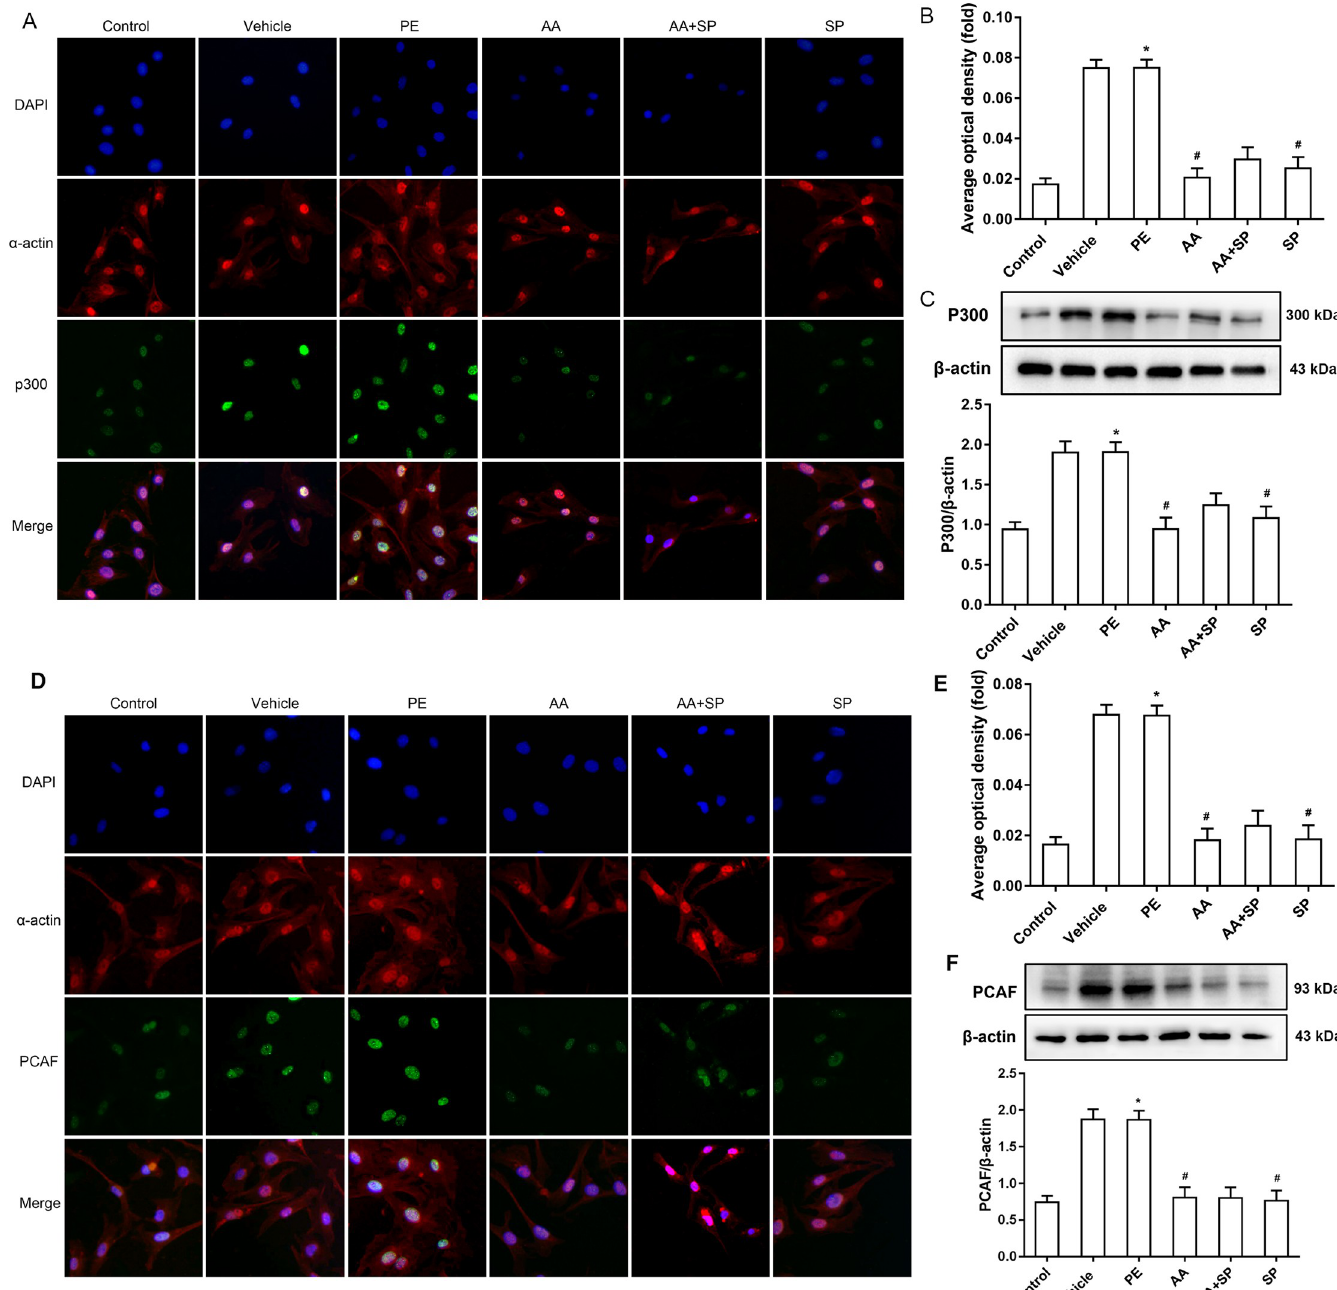
Fig 4. Effects of anacardiac acid (AA) and the JNK inhibitor SP600125 on the expression of HATs in phenylephrine (PE)-induced hypertrophic cardiomyocytes. (A) P300 (green fluorescence) and α -actin (red fluorescence) combined with DAPI (blue fluorescence) staining of myocardial cells exposed to six different conditions. Scale bars, 20 μ m. (B) The statistical analysis of average optical density of P300 immunofluorescence in the six groups. (C) The levels of P300-HAT (histone acetyltransferase) significantly increased in the hypertrophic cardiomyocytes induced by PE; the HATs inhibitor AA and the JNK inhibitor SP600125 prevented this effect. (D) PCAF (green fluorescence) and α -actin (red fluorescence) combined with DAPI (blue fluorescence) staining of myocardial cells exposed to six different conditions. Scale bars, 20 μ m. (E) The statistical analysis of average optical density of PCAF immunofluorescence in the six groups. (F) The level of PCAF-HAT was increased significantly in hypertrophic cardiomyocytes induced by PE compared to that in control cells. The HATs inhibitor AA or the JNK inhibitor SP600125 normalized the expression of PCAF-HAT in PE-induced hypertrophic cardiomyocytes. � P < 0.05 vs . the control group, # P < 0.05 vs . the PE group (n = 6). PE: phenylephrine; DMSO: dimethylsulfoxide; AA: anacardic acid; SP: SP600125 (JNK inhibitor). Fluorescence quantification was done using ImageJ 1.8.0_112 software (https://imagej.nih.gov/ij/, 1997–2018). Figure created in IBM SPSS version 25 (https://www.ibm.com/analytics/spss-statistics-software). The images in this figure were analyzed using Quantity One software Version 4.4 (https://www.bio-rad.com/).